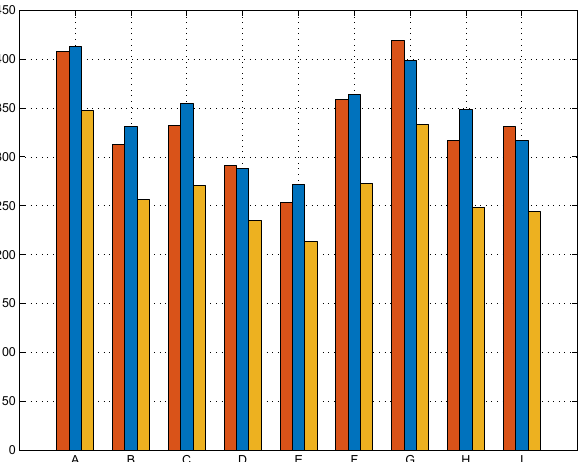
Figure 10. Number of cyclonic eddies formed (red bars) and termi- nated (blue bars) in each sector. The yellow bars indicate the struc- tures formed and terminated in the same